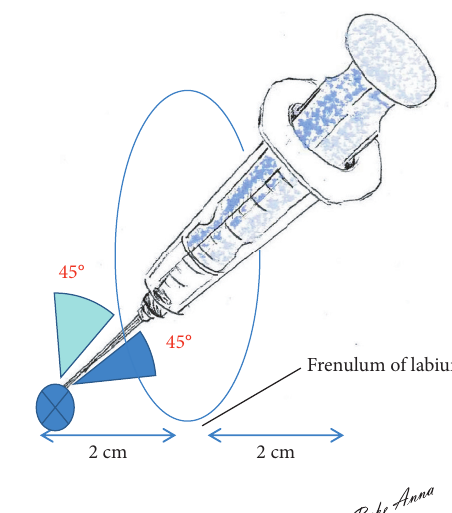
Figure 2: Direction of proper needle insertion. Inserting the needle at a 45-degree angle in 3D (at a 45-degree angle to both the vertical and horizontal planes—directed laterally and downward) provides the most appropriate direction.